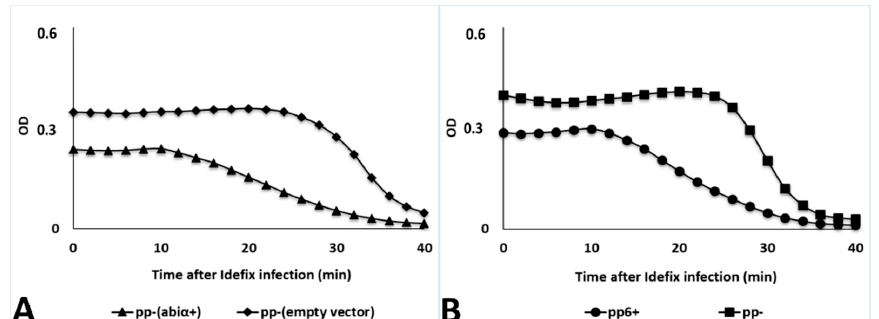
Figure 5. Lysis curves after Idefix infection at MOI 10. ( A ) Comparison between pp − pJIM2246 abi α + (VEJL5) and pp − pJIM2246 (VEJL4) in triangles and diamonds, respectively. ( B ) Comparison between pp6 + and pp − in circles and squares, respectively. The results shown are representative of three biological replicates (see Figure S5).